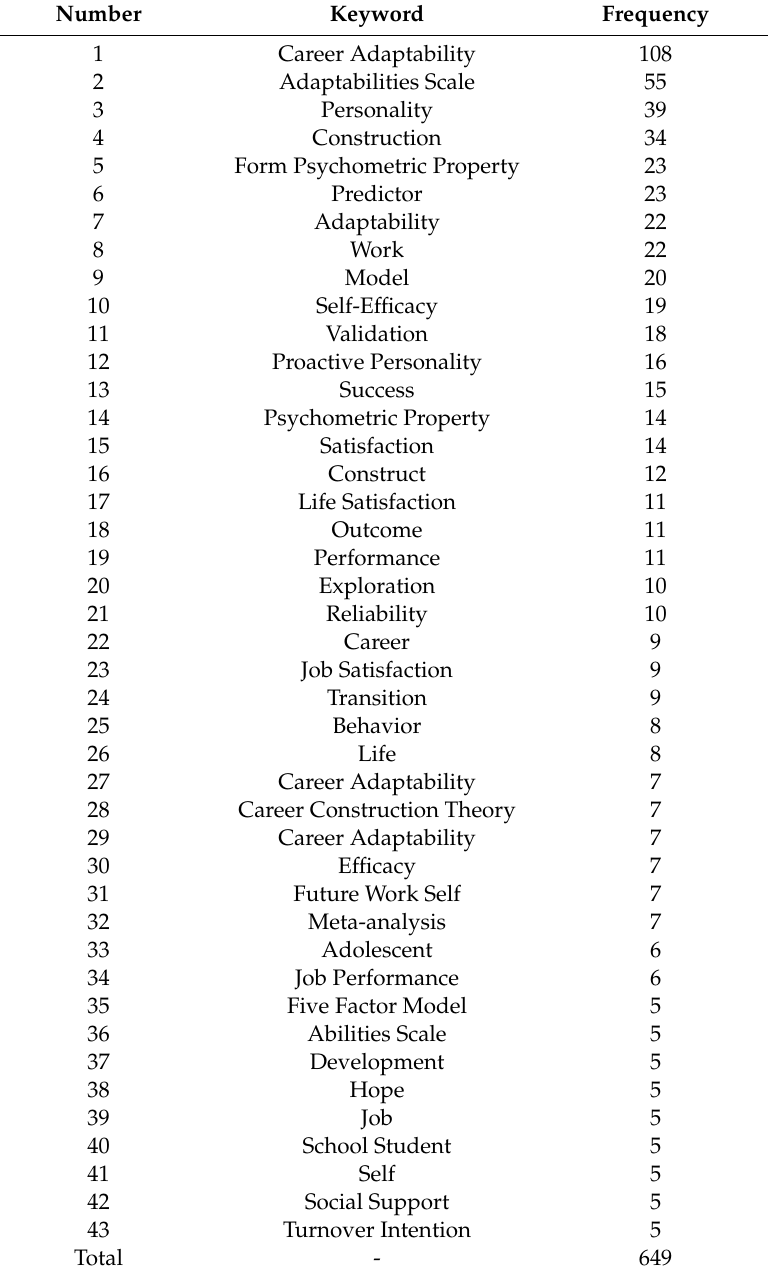
Table 2. Ranking of 43 high-frequency keywords for career